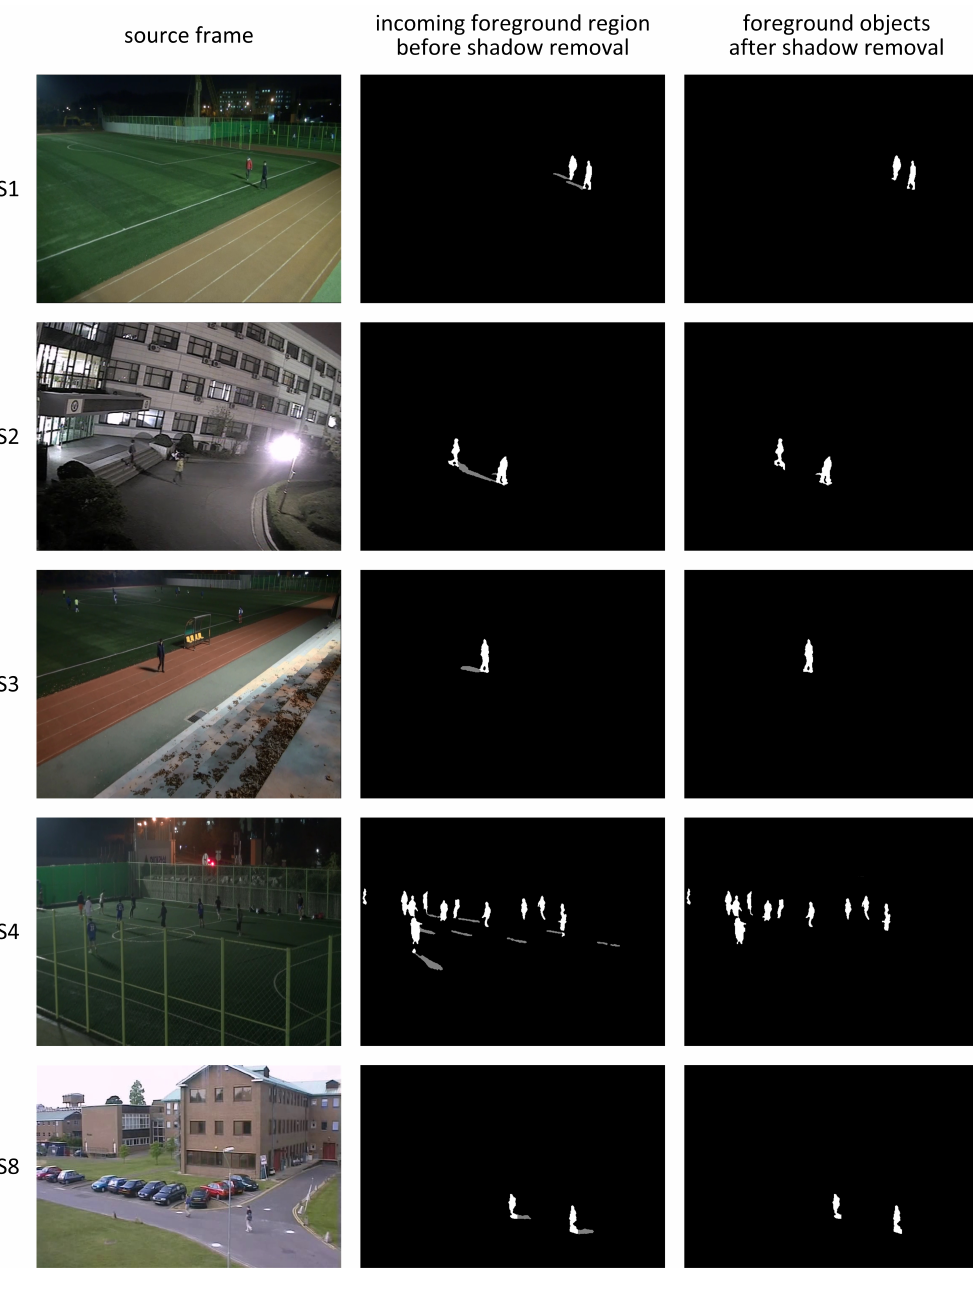
Figure 17. Shadow removal results for various nighttime and one daytime video